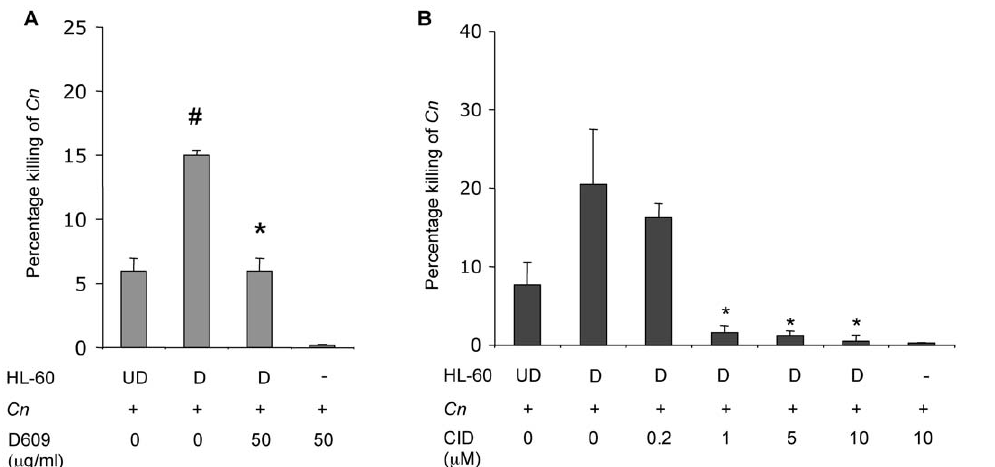
Figure 4. Effect of conditioned media on the killing activity of HL-60 cells. ( A ) Percentage killing of C. neoformans wild-type H99 ( Cn ) by conditioned media collected from HL-60 cells undifferentiated (UD), differentiated (D), from HL60 D treated with D609 or by D609 itself. ( B ) Effect of PKD inhibitor on the killing activity of differentiated HL-60 cells against C. neoformans ( Cn ) or against C. neoformans alone. Percentage killing of Cn wild-type H99 by conditioned media collected from HL-60 cells undifferentiated (UD), differentiated (D) and from HL60 D treated with the PKD1 inhibitor benzoxoloazepinolone (CID755673). # P , 0.05 compared with UD cells. * P , 0.05, compared to untreated D cells.